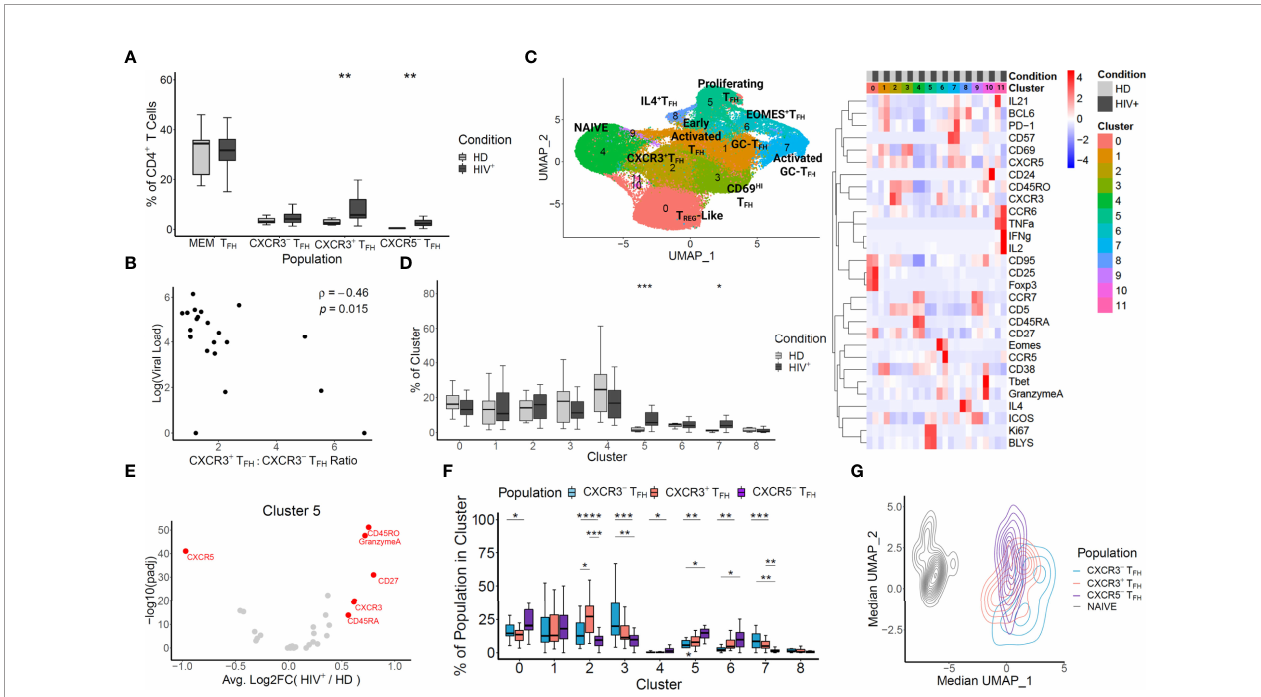
FIGURE 1 | Mass CyTOF reveals an enrichment of non-canonical CXCR3-expressing TFH unique to HIV + lymph nodes. (A) T FH populations were in silico sorted based on the gating illustrated in Supplementary Figure 1 . The frequencies of HIV + and HD LN cells within each population were compared with a t-test. (B) CXCR3 + T FH , CXCR3 - T FH , CXCR5 - T FH and T cells were in silico sorted, visualized with UMAP, and clustered (left). Clusters were annotated based on the heatmap of the markers shared across each experiment (right). (C) Log pVL and the ratio of CXCR3 + T FH to CXCR3 - T FH frequencies were compared for each donor using a Spearman ’ s rank correlation coef fi cient. (D) The frequencies of HIV + patient cells versus HD cells for each donor within each cluster from B were compared using a Wilcox test. (E) Differential expression HIV + versus HD derived cells in cluster 5 was calculated for each marker based on a likelihood-ratio test. (F) Pairwise frequencies of in silico sorted T FH within each cluster (HIV + donors only) was compared using a t-test. (G) The median UMAP coordinates were calculated for each donor in silico sorted populations and projected onto the same coordinates as in (B) Signi fi cance: ****p < 0.0001; ***p < 0.001; **p < 0.01; *p < 0.05; ns p ≥